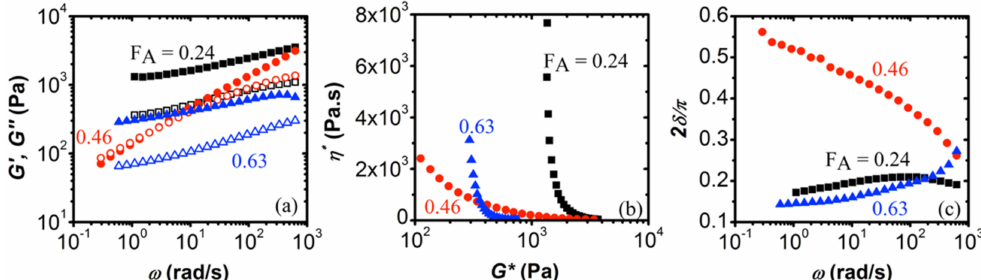
Figure 2. Frequency sweep data for coacervates of HA/CHI with different F A plotted as ( a ) elastic modulus G (cid:48) and loss modulus G ” vs. frequency ω . The closed and open data points in Figure 2a are for G (cid:48) and G ”, respectively. ( b ) Normalized phase angle (2 δ / π ) vs. angular frequency ( ω ). ( c ) Complex viscosity ( η ∗ ) vs. complex modulus ( G *) for HA/CHI coacervates. Black squares, red circles, and blue triangles are data points for HA/CHI coacervates with F A of 0.24, 0.46, and 0.63, respectively. HA had a molecular weight of 132.3 kDa, while weight-average molecular weight of CHI was similar, i.e., 345.6 kDa, 365.1 kDa, and 332.4 kDa for F A = 0.24, 0.46, and 0.63,